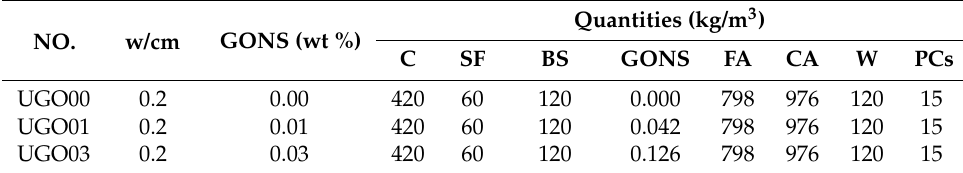
Table 2. Mixture proportions of ultra-high strength concrete incorporating graphene oxide nanosheets (GONSs). C, cement; SF, silica fume; BS, ground granulated blast-furnace slag; FA, fine aggregate; CA, coarse aggregate; W, water; PCs, polycarboxylate-based superplasticizer. Quantities (kg/m 3 ) NO. w/cm GONS (wt %)